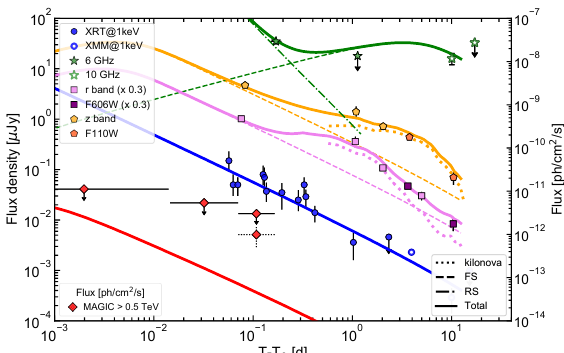
Figure 11. GRB 160821B: multi-wavelength light curves (from radio to TeV) and their modeling according to [145]. ©AAS. Reproduced with permission. The different contributions from the forward shock (FS), reverse shock (RS) and kilonova are shown (see legend).